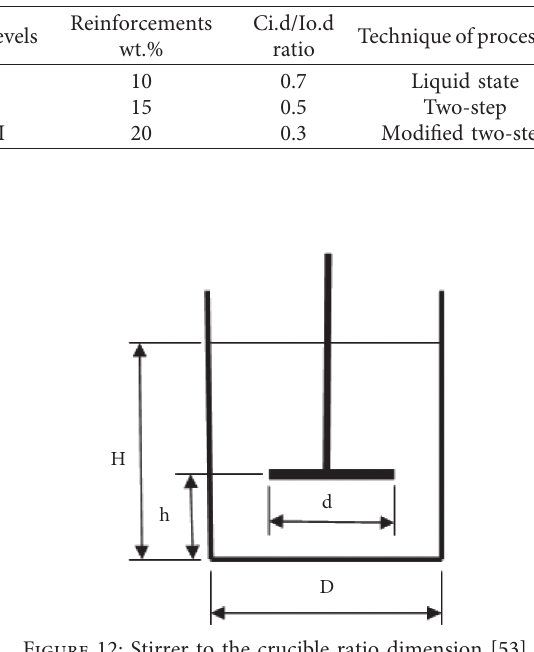
Table 1: Factors and levels [52].